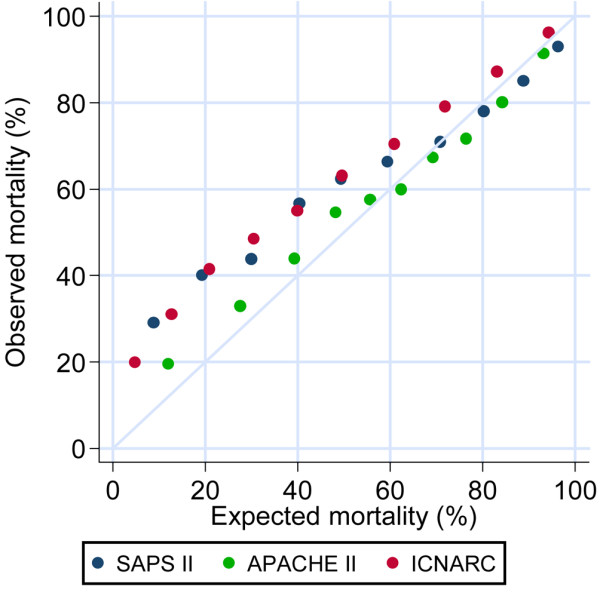
Calibration plot of SAPS II, APACHE II and ICNARC physiology scores. A comparison of the goodness-of-fit of the SAPS II, APACHE II and ICNARC physiology scores.